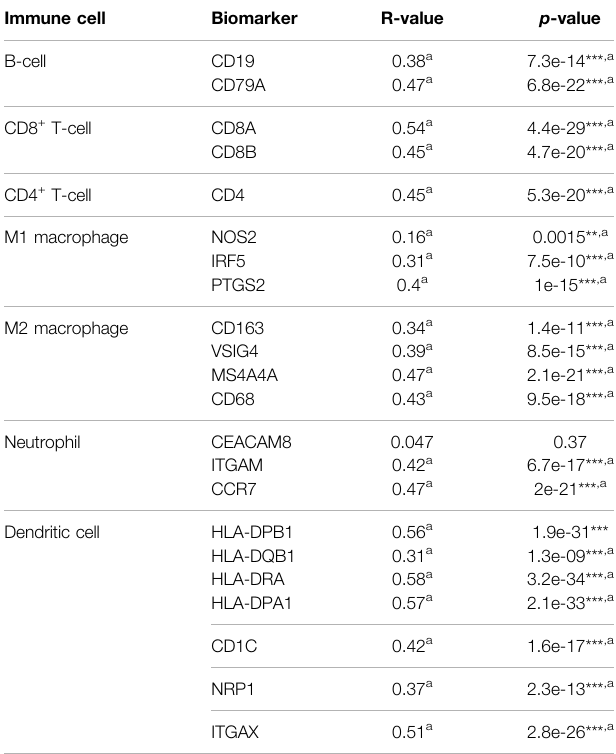
TABLE2| CorrelationanalysisbetweenSTAT1andbiomarkersofimmunecellsin HCC (GEPIA). Immune cell